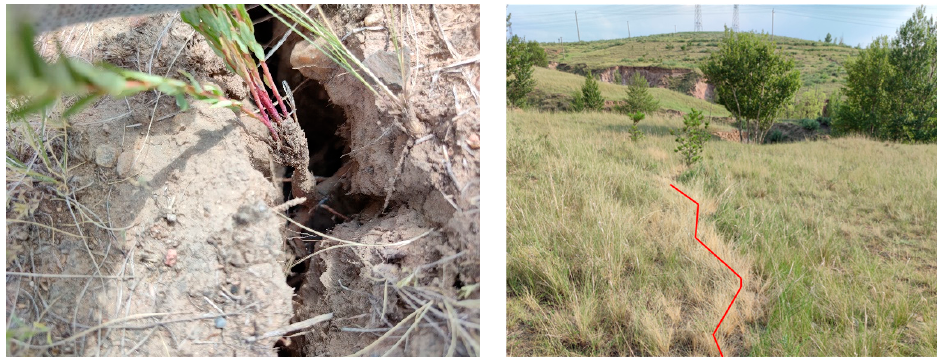
Figure 9. Even if there are fissures, the roots of Ck will not easily break. Ck can continue to live (left figure). However, Sb is more likely to die (there are fissures where the red line is marked on the figure) (right figure). Source: Built on the basis of the author’s field survey.